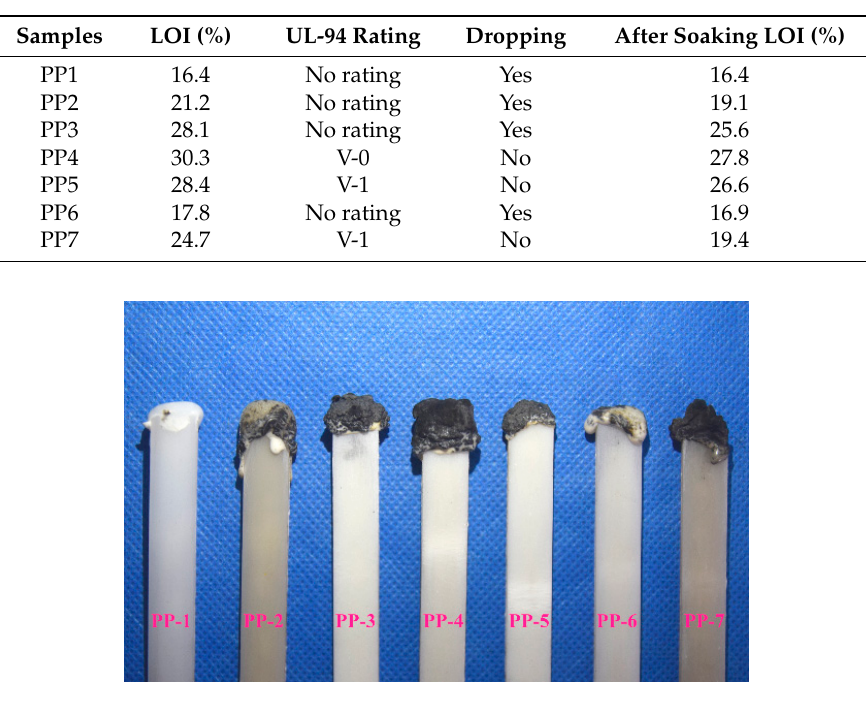
Figure 9. Heat release rate ( a ) and total heat release ( b ) curves of PP and PP composites.